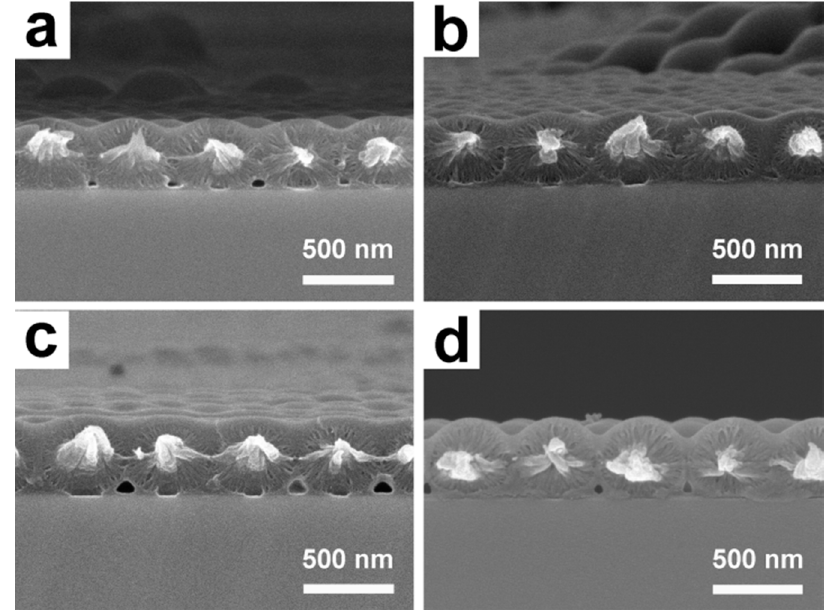
Figure 5. SEM images of UPPGF-4 after equilibration in buffer solution at: pH 5.08 ( a ); pH 4.20 ( b ); pH 3.39 ( c ); and pH 2.57 ( d ).